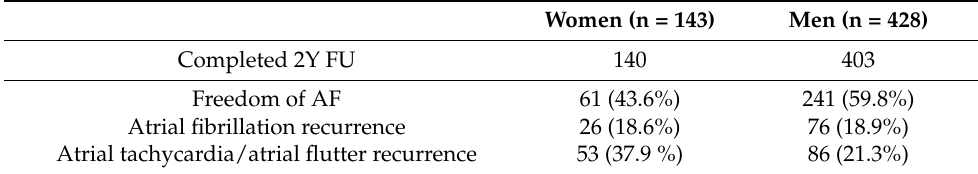
Figure 1. Kaplan–Meier analysis of women and men during two years follow-up. Men: solid blue line, women: dashed red line. AF = atrial fibrillation. Table 2. Recurrence